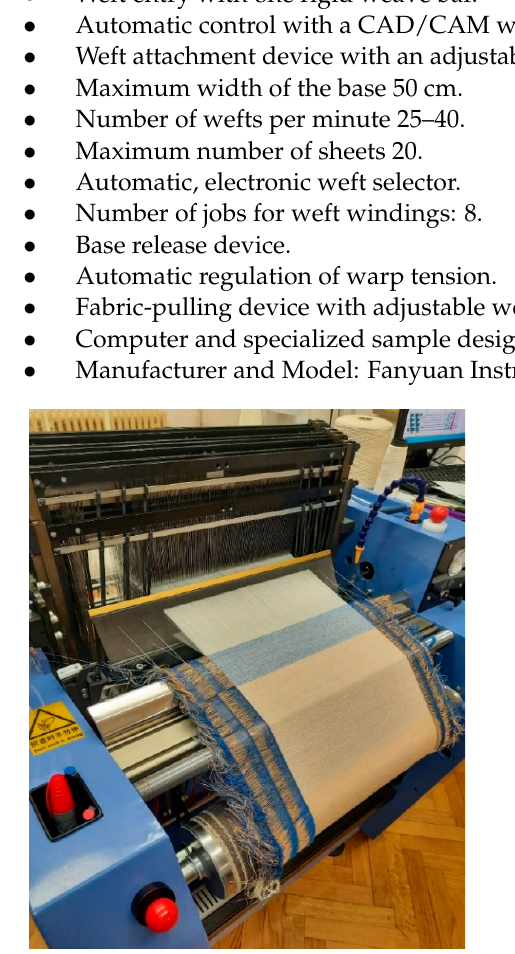
Figure 4. Laboratory weaving machine.